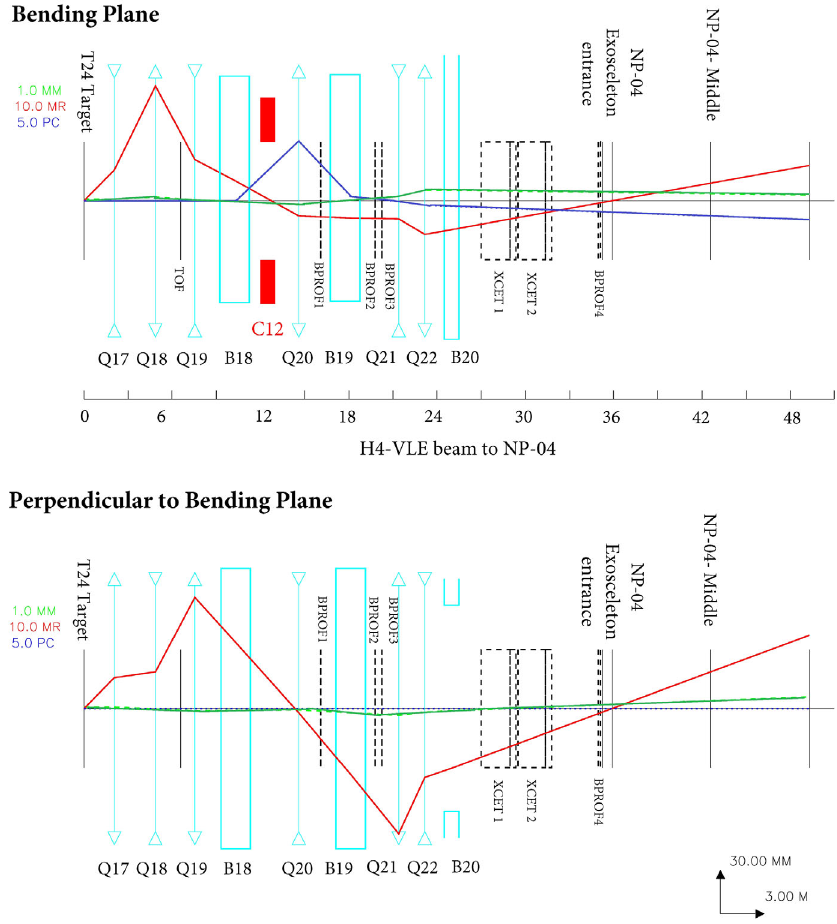
FIG. 8. Similar to Fig. 7 for the case of the H4-VLE